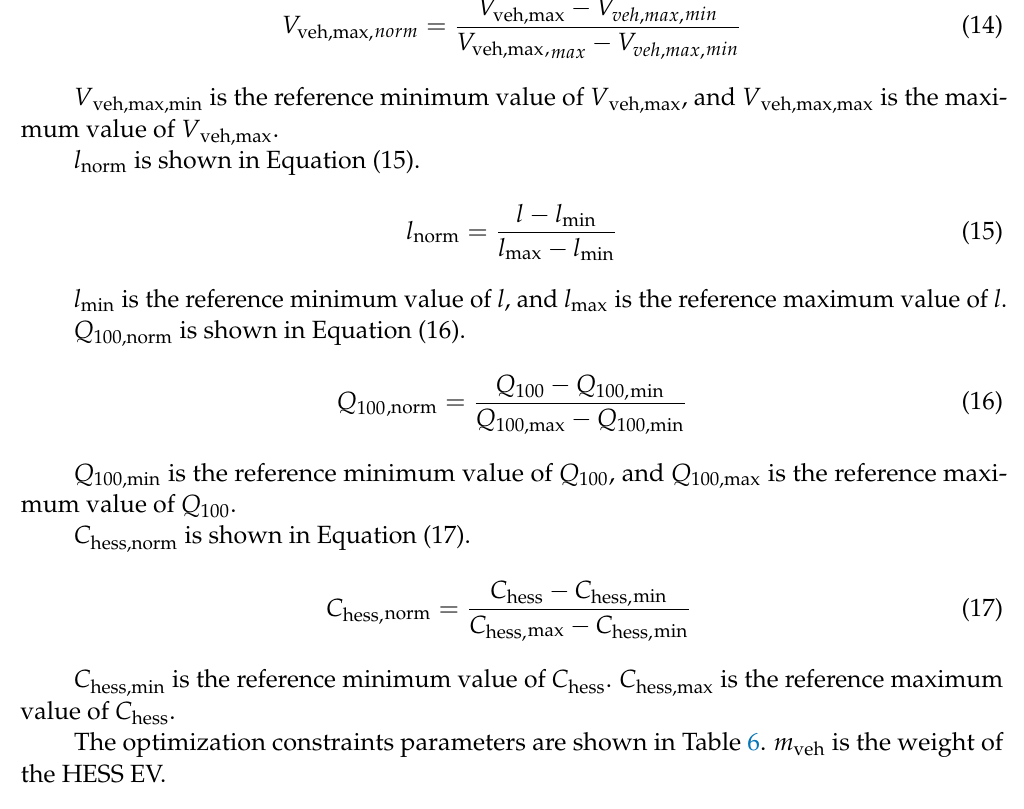
Table 6. The optimization constraints parameters.